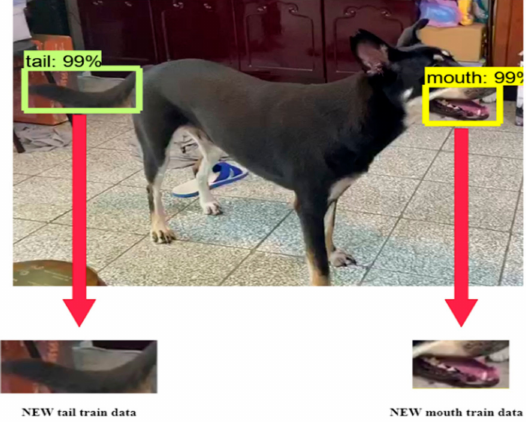
Figure 4. Retraining data samples.